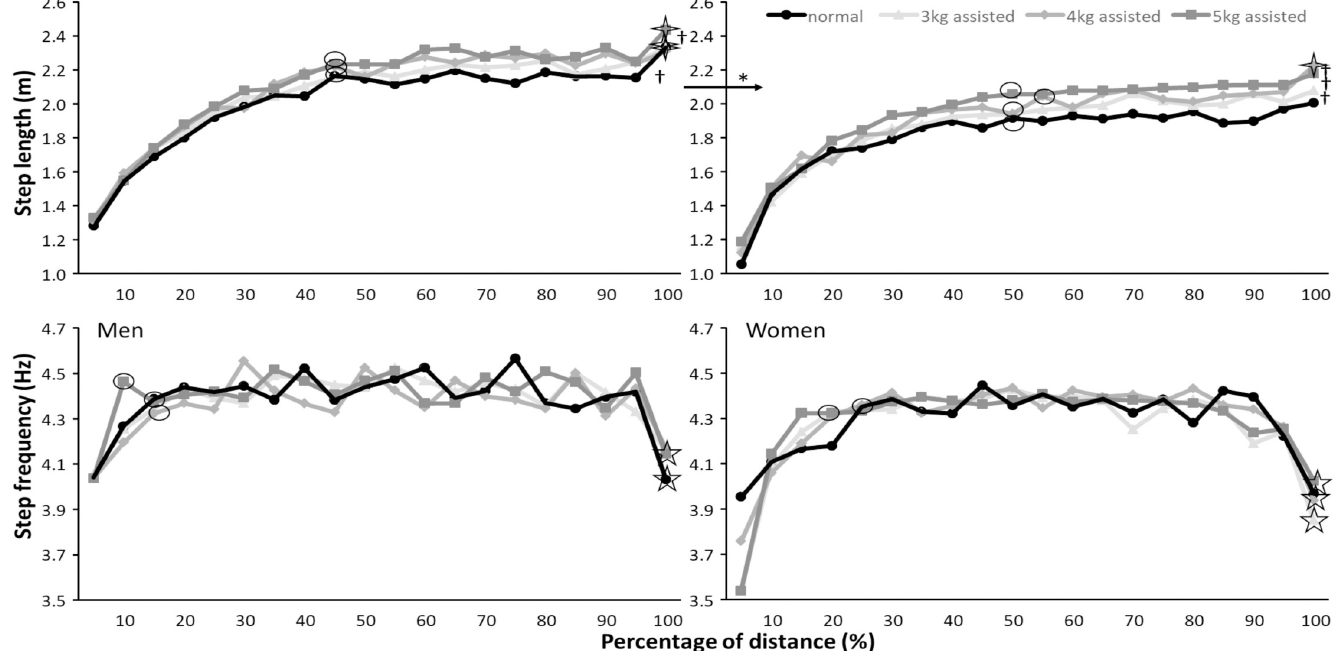
Fig 4. Average step length and frequency ( ± SEM) per 5% of the distance during normal and 3, 4, and 5 kg assisted 60 m sprints for men and women. � indicates a significant difference between men and women for each of the sprint conditions. † indicates a significant difference between these two sprint conditions. ʘ indicates where maximal/minimal values were reached before plateau for this condition. indicates where maximal values increased for this condition. indicates where values decreased again for this condition.